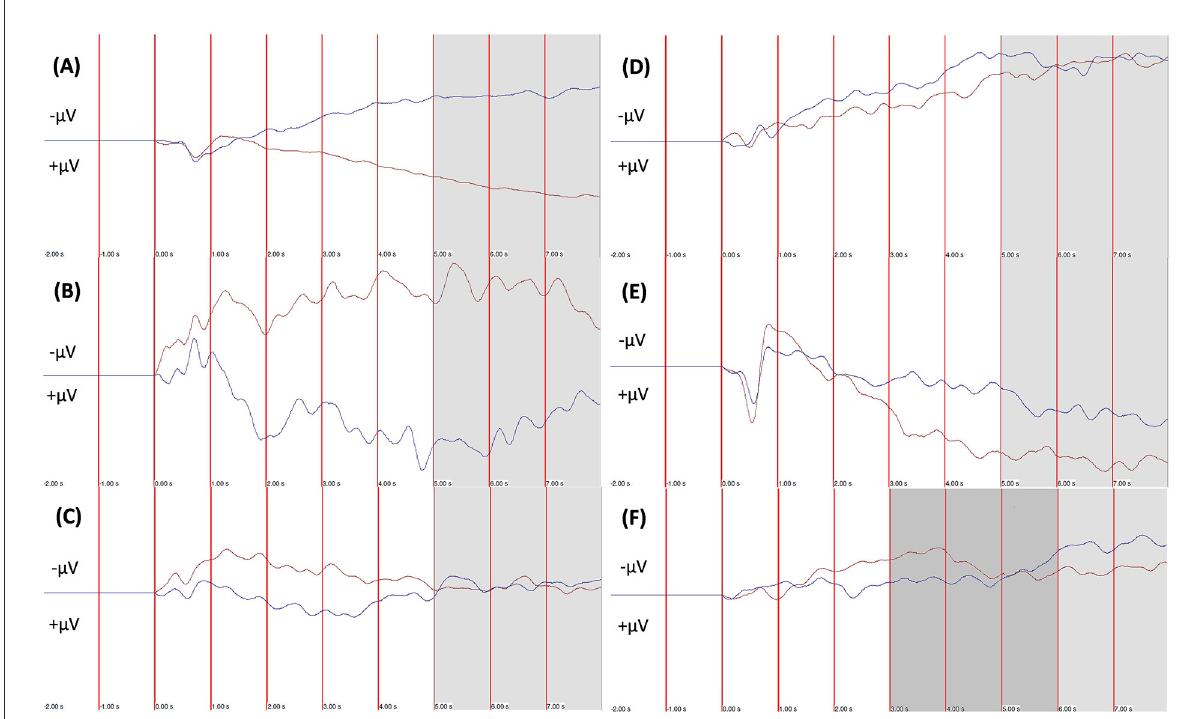
FIGURE2 Visualization of the variation of SCP-nf outcomes. The red-line illustrates mean amplitude for all positivation (deactivation) trials, the blue-line illustrates mean amplitude of all negativation (activation) trials. The gray-area indicates last 3 seconds of active phase (5–8s). (A) Profile of a “regulator,” with both negativation and positivation on correct side in relation to baseline. (B) Profile of a “inverted-regulator.” There is a clear differentiation between activation and deactivation, but in the opposite direction as instructed. (C) Profile of a “non-regulator.” There are barely any differences between activation and deactivation, as both are fluctuating around the baseline. (D) Profile of successful deactivation, and differentiation. Althou, activation trials have a lower amplitude than the deactivation trials, their mean is not negative (i.e., wrong side of baseline). (E) Profile of successful activation. However, the deactivation trials mimic the activation trials, hence there is merely any differentiation. (F) Profile of successful activation and differentiation based on the time measure 5–8s. However, based on the time measure 3–6s (dark gray area), as used in most studies not using the NeuroConn system, the profile would show an inverted-differentiation at